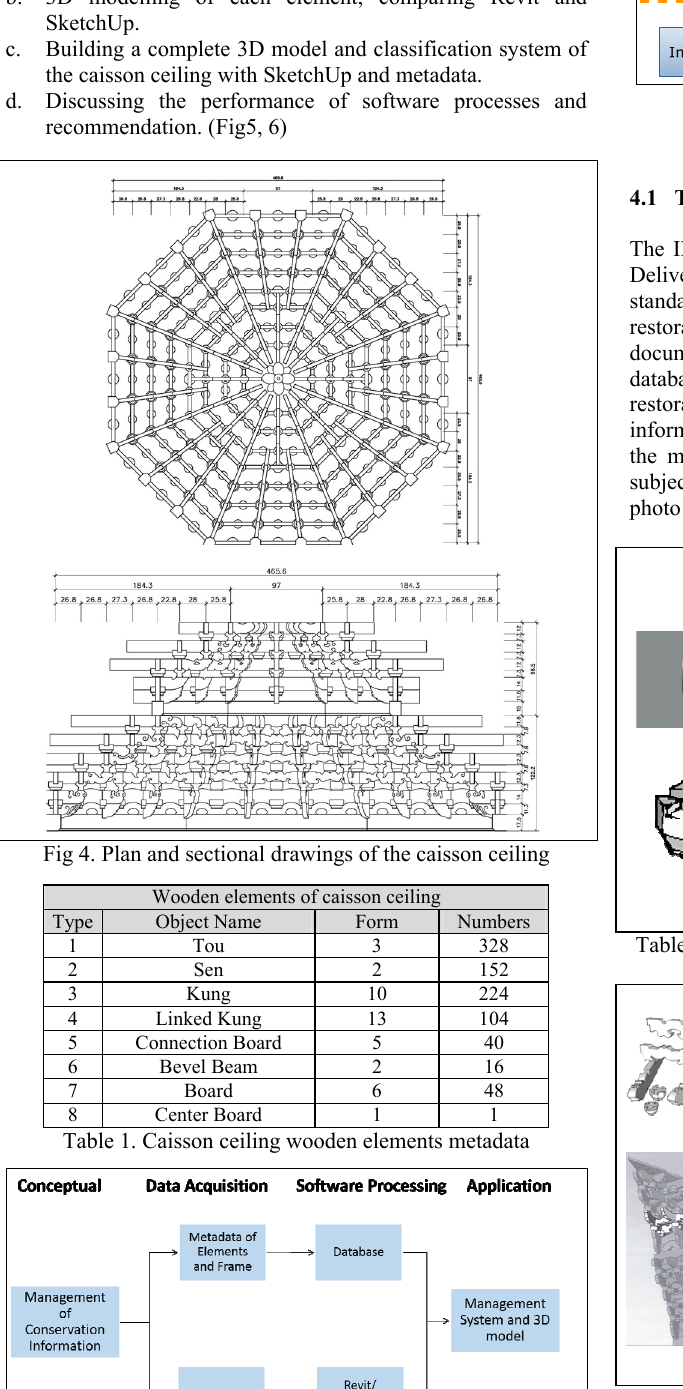
Fig 3. Section of the temple structure (above) and the caisson ceiling (below, highlighted)